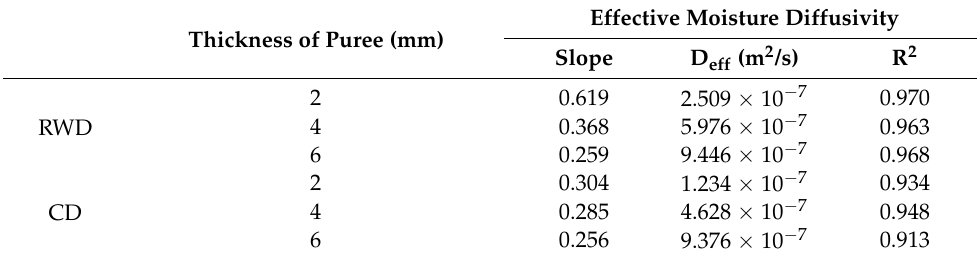
Table 3. Effective moisture diffusivity values for different